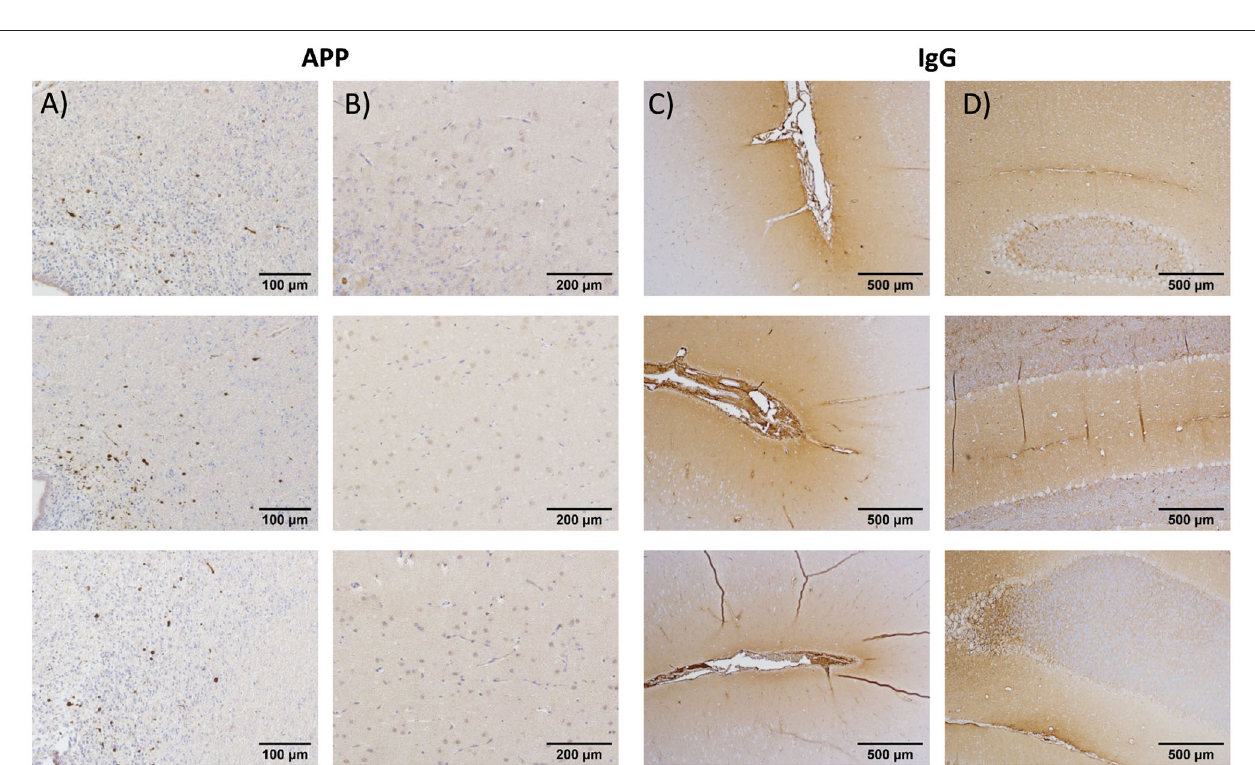
FIGURE 3 | Immunohistochemistry results from, respectively, the periventricular region at the level of the caudate nucleus (A) and at the vermis of the cerebellum for amyloid precursor protein (B) for selected animals from the initial testing cohort (experiment 1). Periventricular region (C) and vermis of cerebellum (D) : present data from immunoglobulin G (IgG) antibodies. The results indicated robust evidence of blood–brain barrier breach (IgG) in both the periventricular region and cerebellum, whereas diffuse axonal injury was limited to the cortical and periventricular regions at ∼ 5h post-injury.